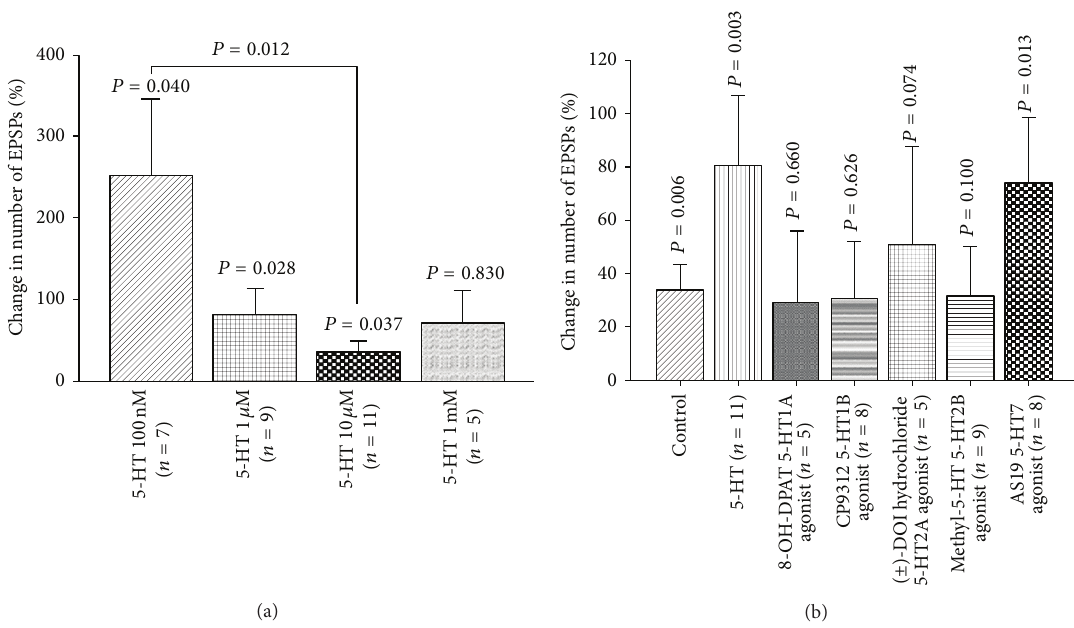
Figure 12: 5-HT and sensory-motor function modulation in third-instar larvae. (a) Dose-response relationship of 5-HT in sensory-motor physiology. 5-HT significantly increased the frequency of EPSPs. The EPSPs of 8 stimulations were recorded for each saline and after exchanging saline with various 5-HT concentrations. (b) Effect of various 5-HT receptor agonists on the frequency of EPSPs in third-instar larvae. Application of 5-HT and 5-HT7 agonist significantly increased the number of EPSPs. The segmental nerve was stimulated at 40Hz, 10 pulses, and the EPSPs were recorded from muscle fiber 6 or 7. Seven to ten stimulations were analyzed in each saline and after exchanging saline with a saline that contained agonist or in case of the controls fresh saline was used. Paired 𝑡 -test was used to compare the number of EPSPs in saline and saline that contained an agonist. Data represented as mean ± SEM. 𝑃 < 0.05 is